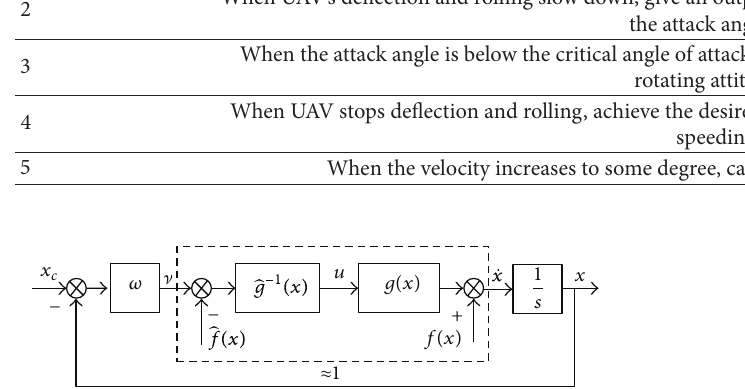
Figure 1: The structure of dynamic inversion compensation for affine nonlinear